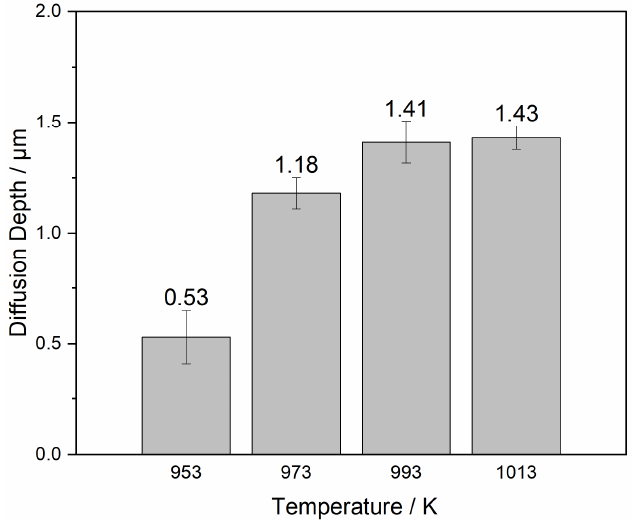
Figure 10. Thickness of vanadium deposition layer on the surface of cathode plate at different tem-